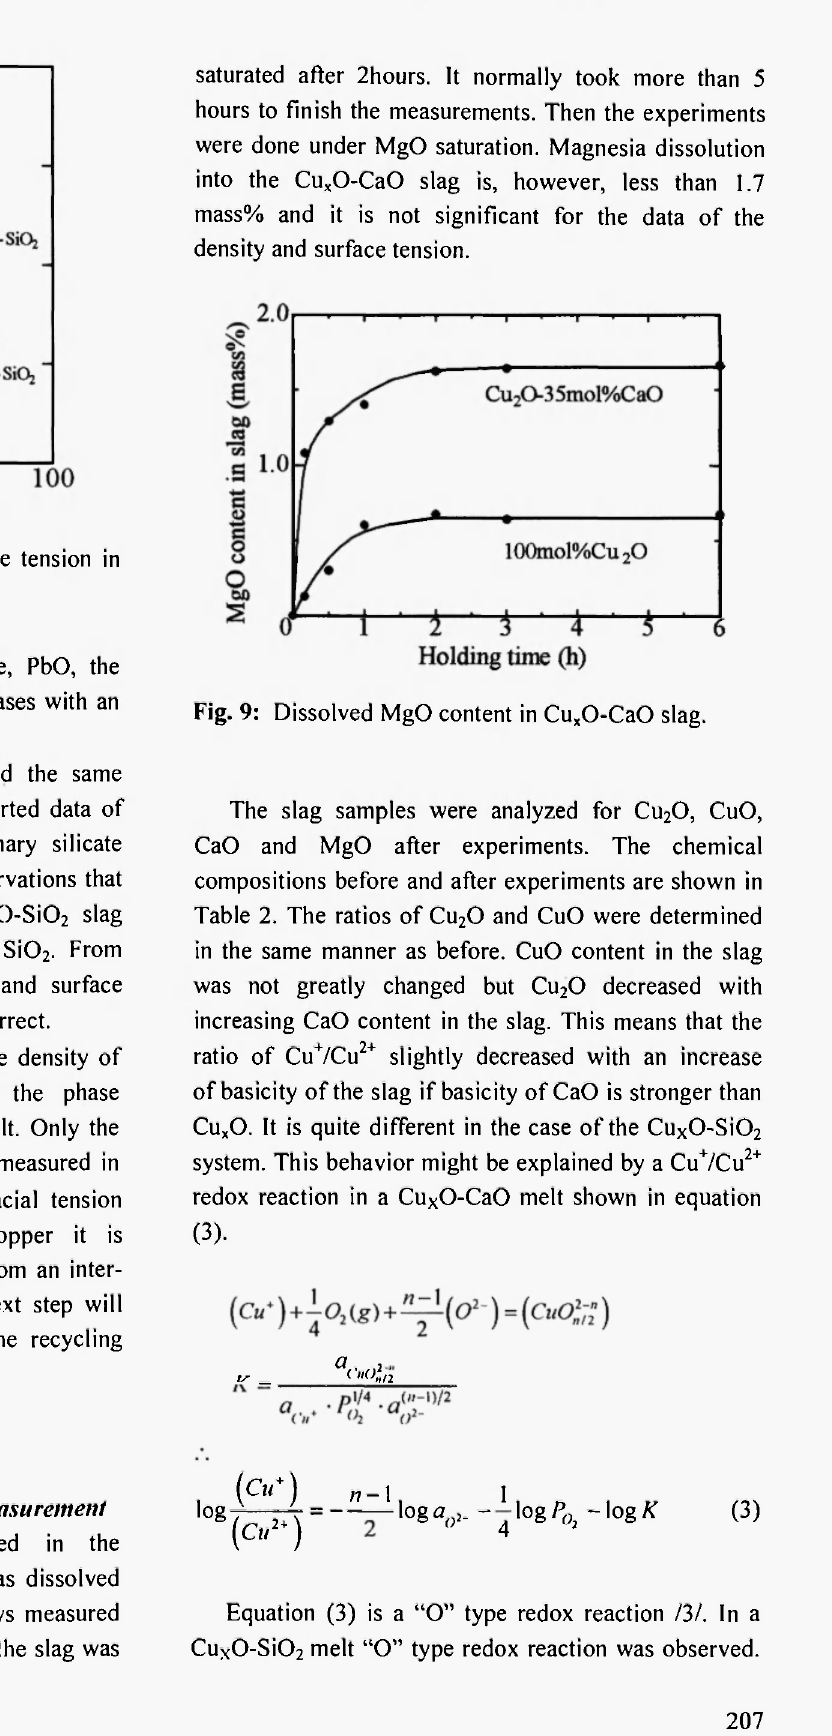
Equation (3) is a "O" type redox reaction /3/. In